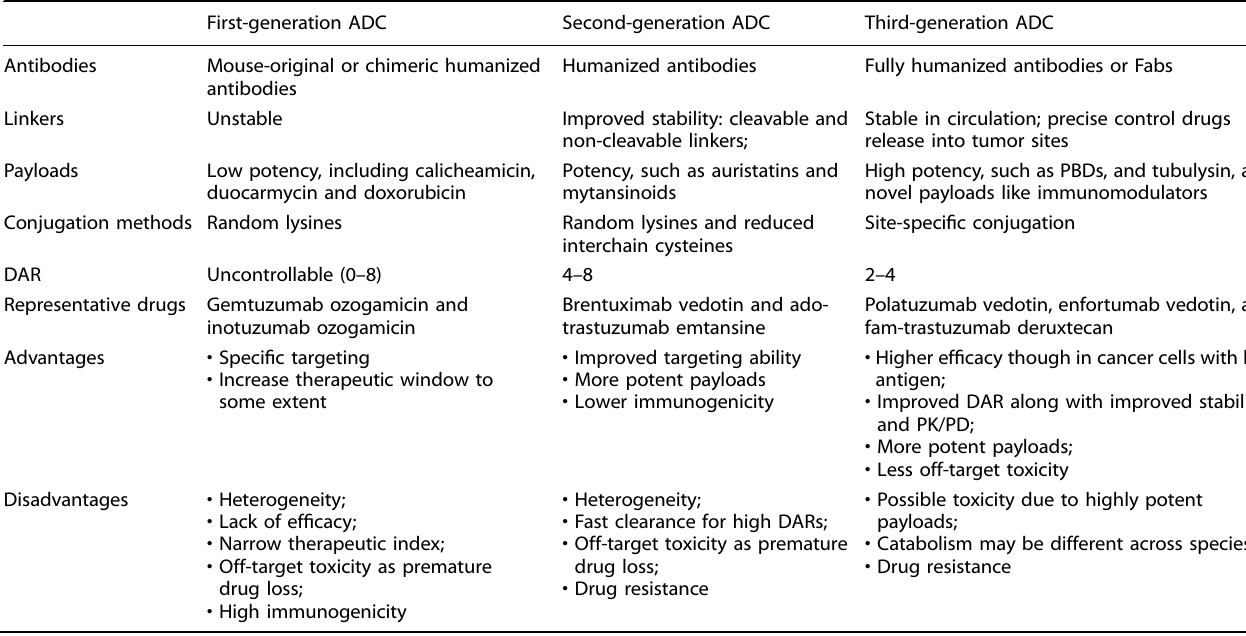
Table 3. The evolution of the ADC drug